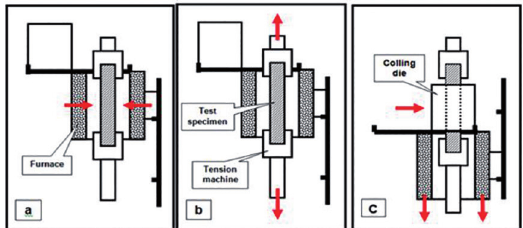
Figure 1: Schematic diagram of the experimental apparatus (a) heating system (furnace), (b) deformation system (mechanical test machine) and (c) cooling die.